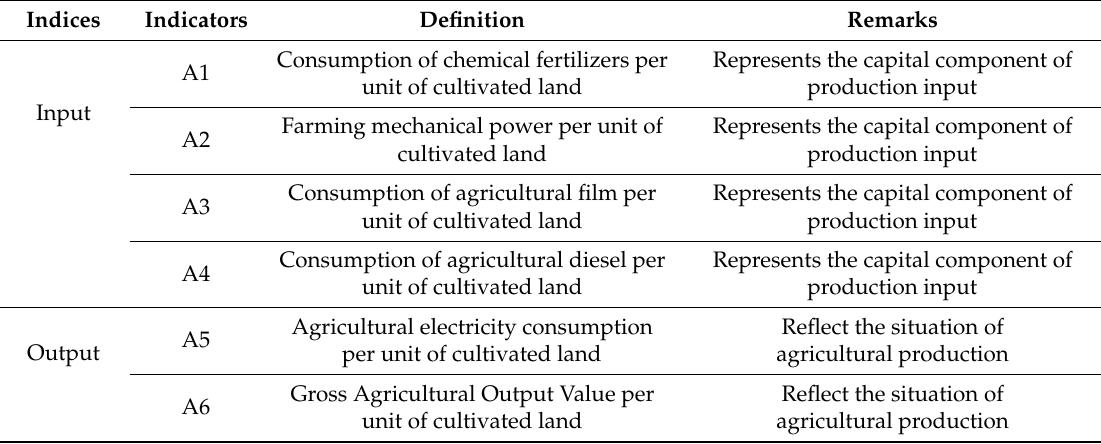
Table 1. The Indicators of Agricultural Land Use